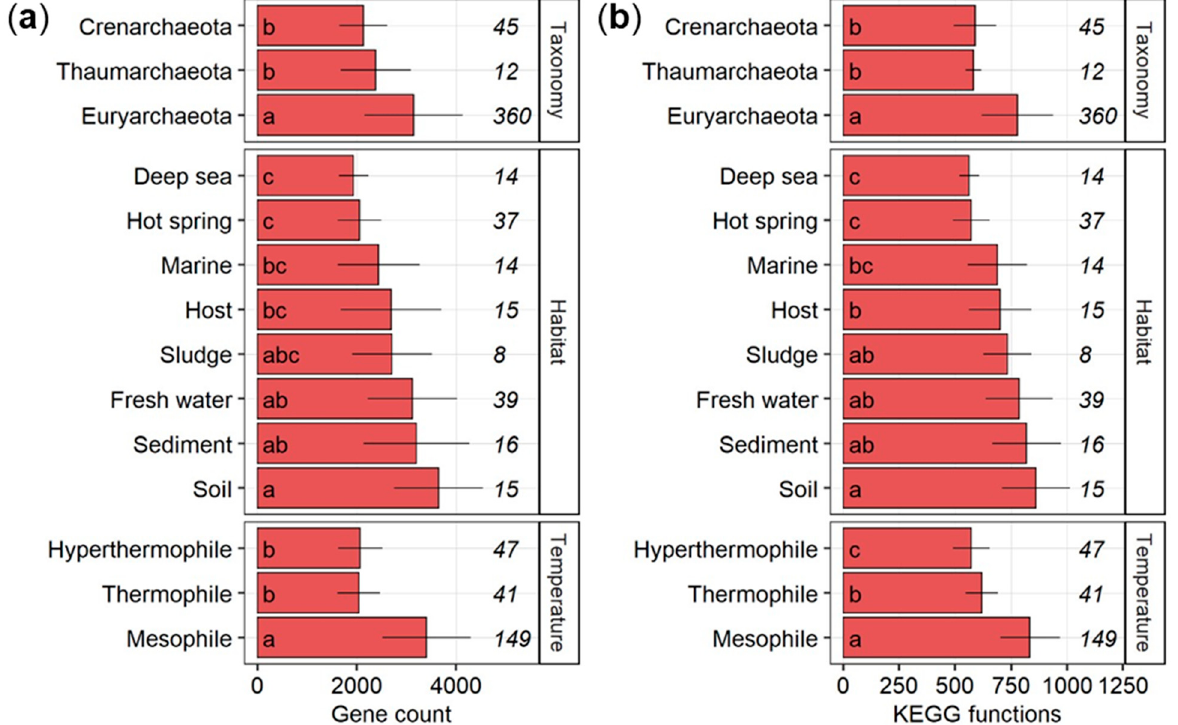
Figure 1. Counts ( a ) and the number of different KEGG functions ( b ) per genome across archaeal phyla, habitats, and temperature ranges shown as average with standard deviation. The number of archaeal genomes is given in italics. Groups followed by a different letter are significantly different according to the HSD-test ( p < 0.05).